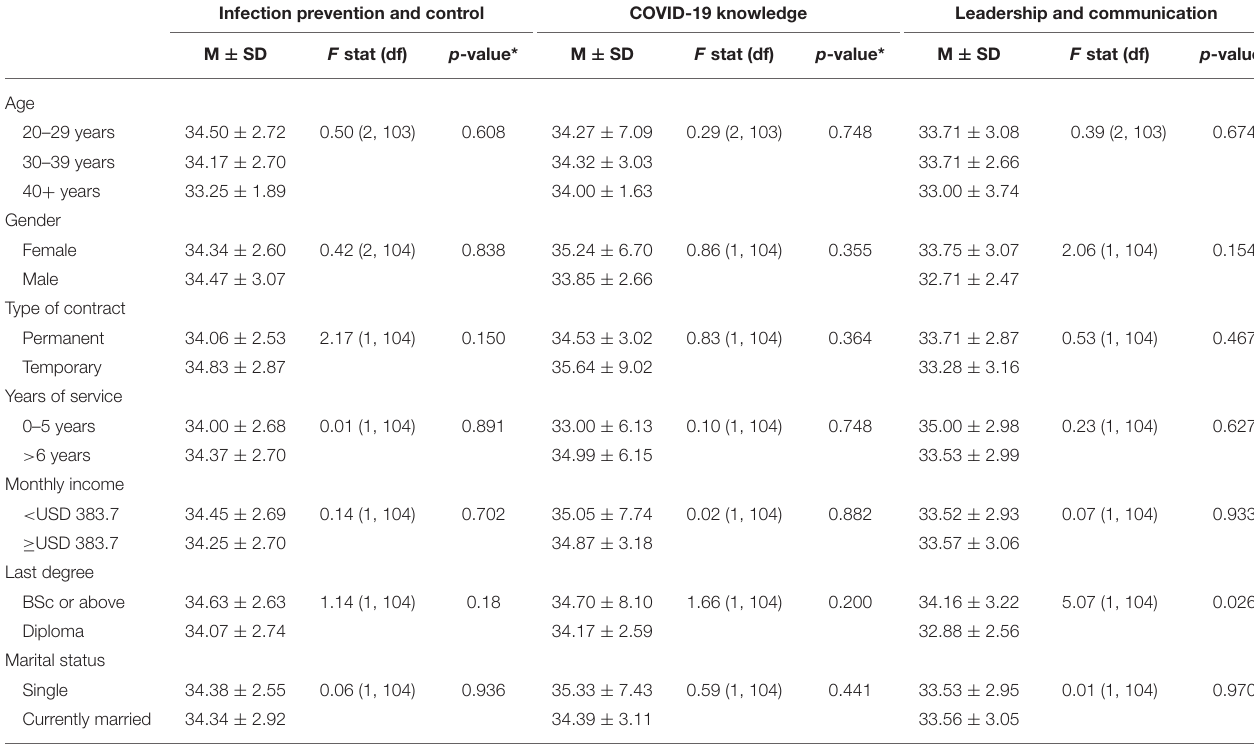
TABLE 5 | Comparative means by socio-demographic characteristics of the intervention group at post-intervention ( n = 106). Infection prevention and control COVID-19 knowledge